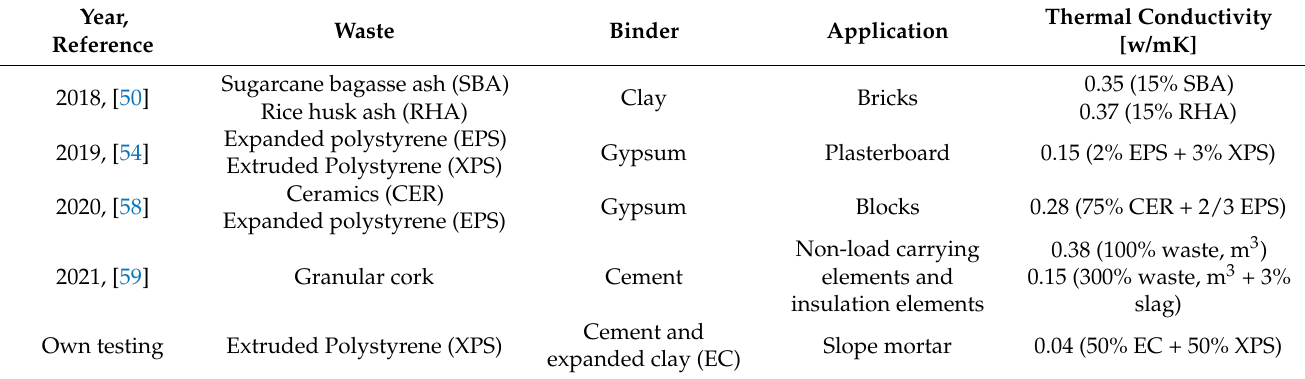
Table 4. Recycled materials selected for the simulations